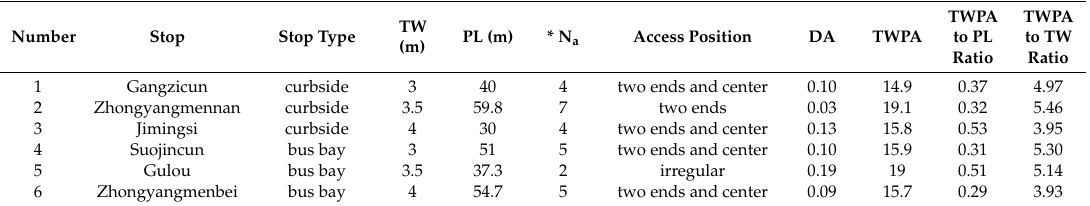
Table 1. Specifications of six bus stops.